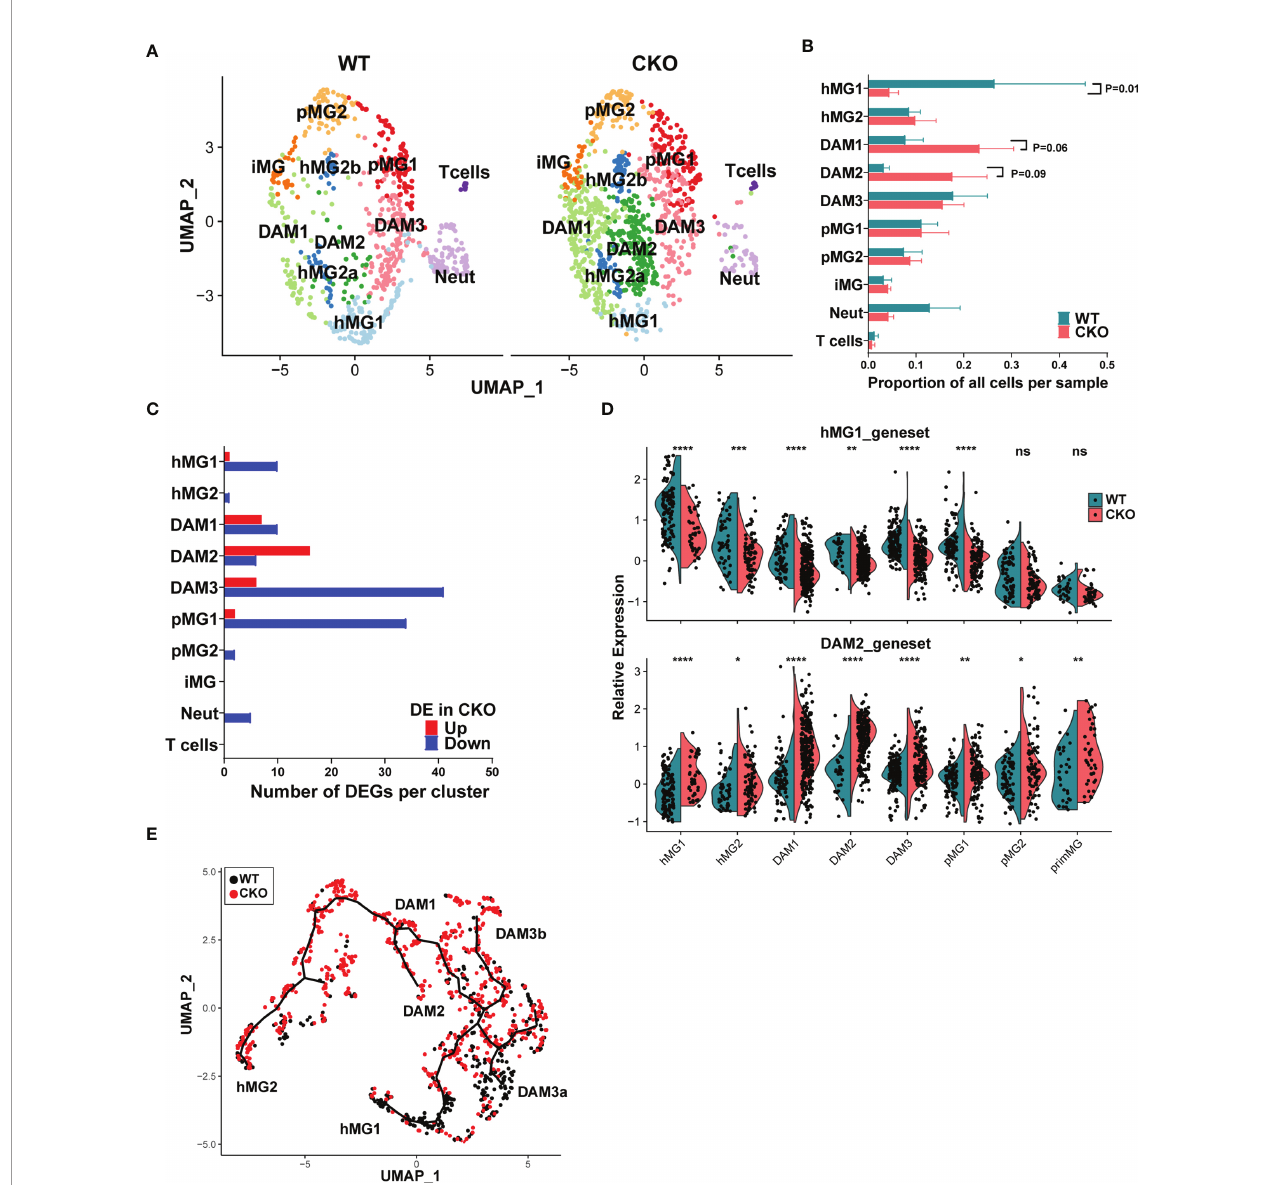
FIGURE 7 | p38 a in male microglia regulates subset-speci fi c gene expression programs and represses the transition from homeostatic to in fl ammatory microglia states. Microglia were isolated from male p38 a CKO Cx3cr1-ER (CKO; n=3) and WT control mice (n=3) during peak EAE and analyzed by scRNAseq as in Figures 5 , 6 . (A) UMAP-based two-dimensional projection of cell clustering of major cell populations and transcriptional states between WT (right) and CKO (left) microglia. (B) Relative proportion of each cell cluster was determined by dividing the number of cells in a given cluster by the total number of cells in a biological replicate. (C) Distribution of genes differentially expressed between WT and CKO across the different cell clusters. Directionality of change in CKO relative to WT is shown. (D) Relative differential expression of the hMG1 (top) and DAM2 (bottom) gene modules across 8 microglial cell clusters. Signi fi cance of differences between WT and CKO are indicated as follows: *P < 0.05; **P < 0.01; ***P < 0.001; ****P < 0.0001; ns, not signi fi cant (P > 0.05). (E) Monocle 3-inferred trajectories between different microglial clusters were determined as in , highlighting the differential distribution of WT and CKO